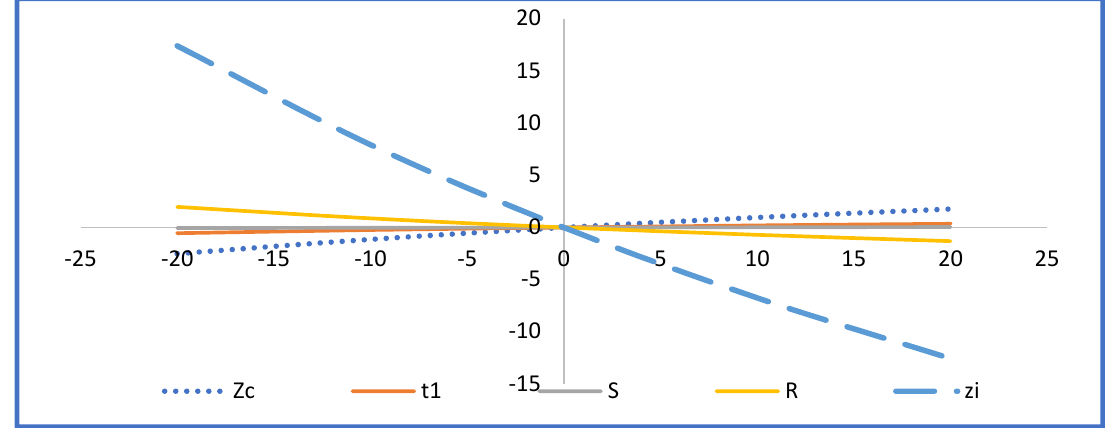
Figure 7. Impact of post optimality analysis of ‘